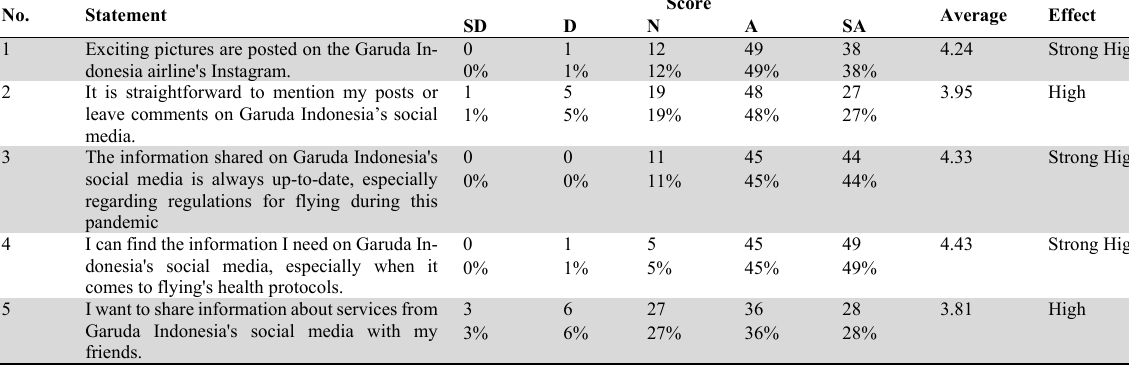
Distribution of Answers to Social Media Marketing Variable